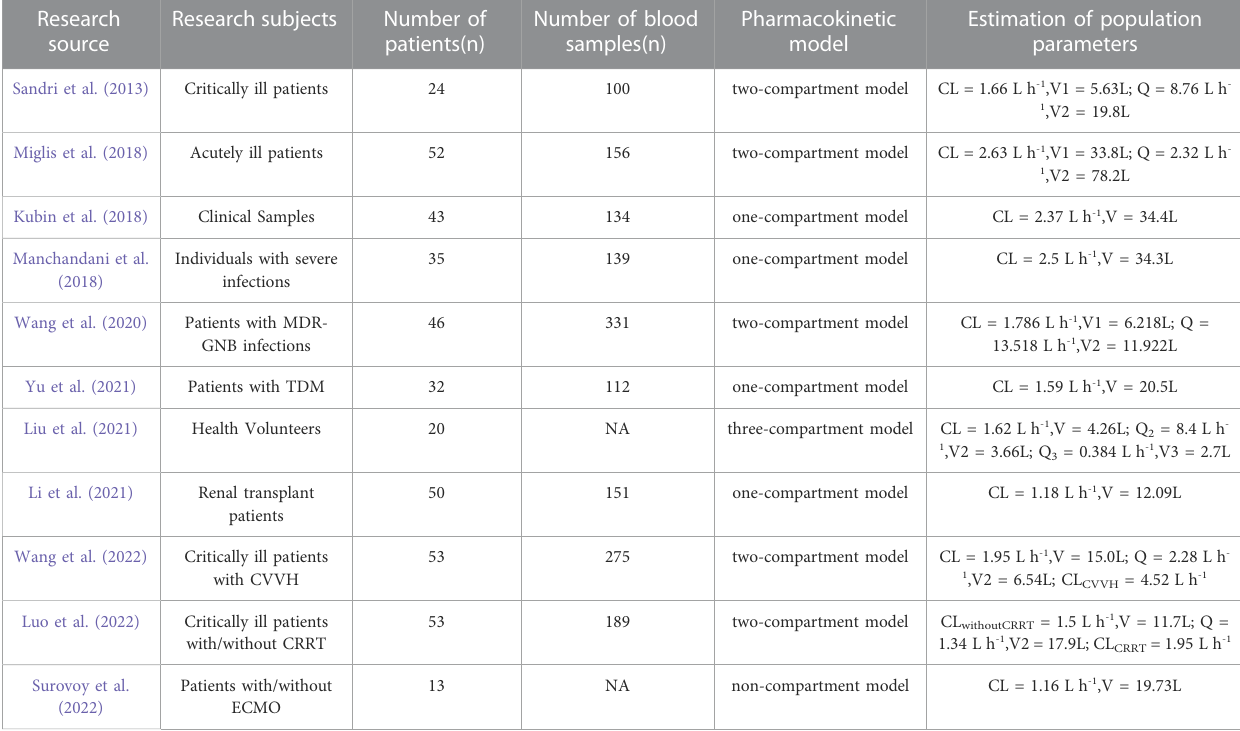
TABLE 5 PPK studies of polymyxin B. Research